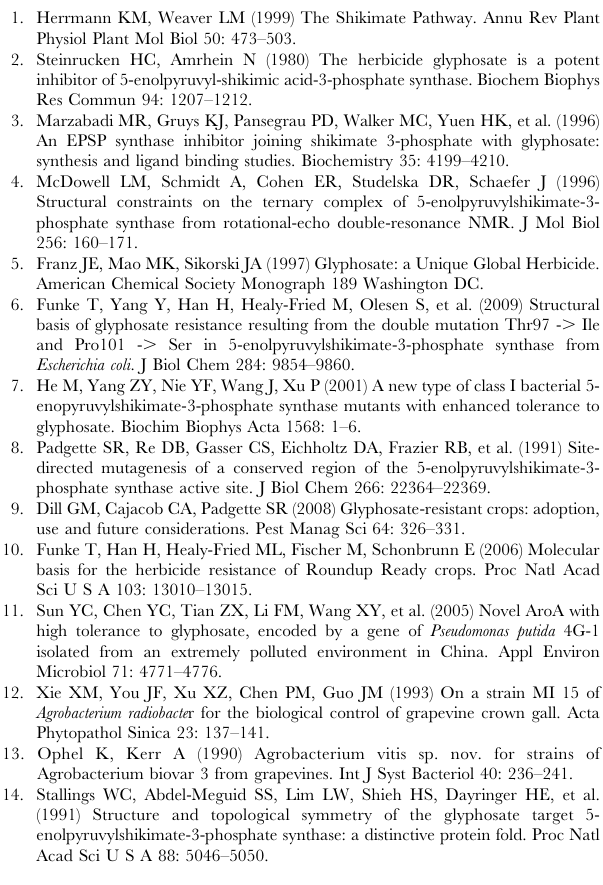
Figure S2 Kinetic properties of AroA E.coli .,